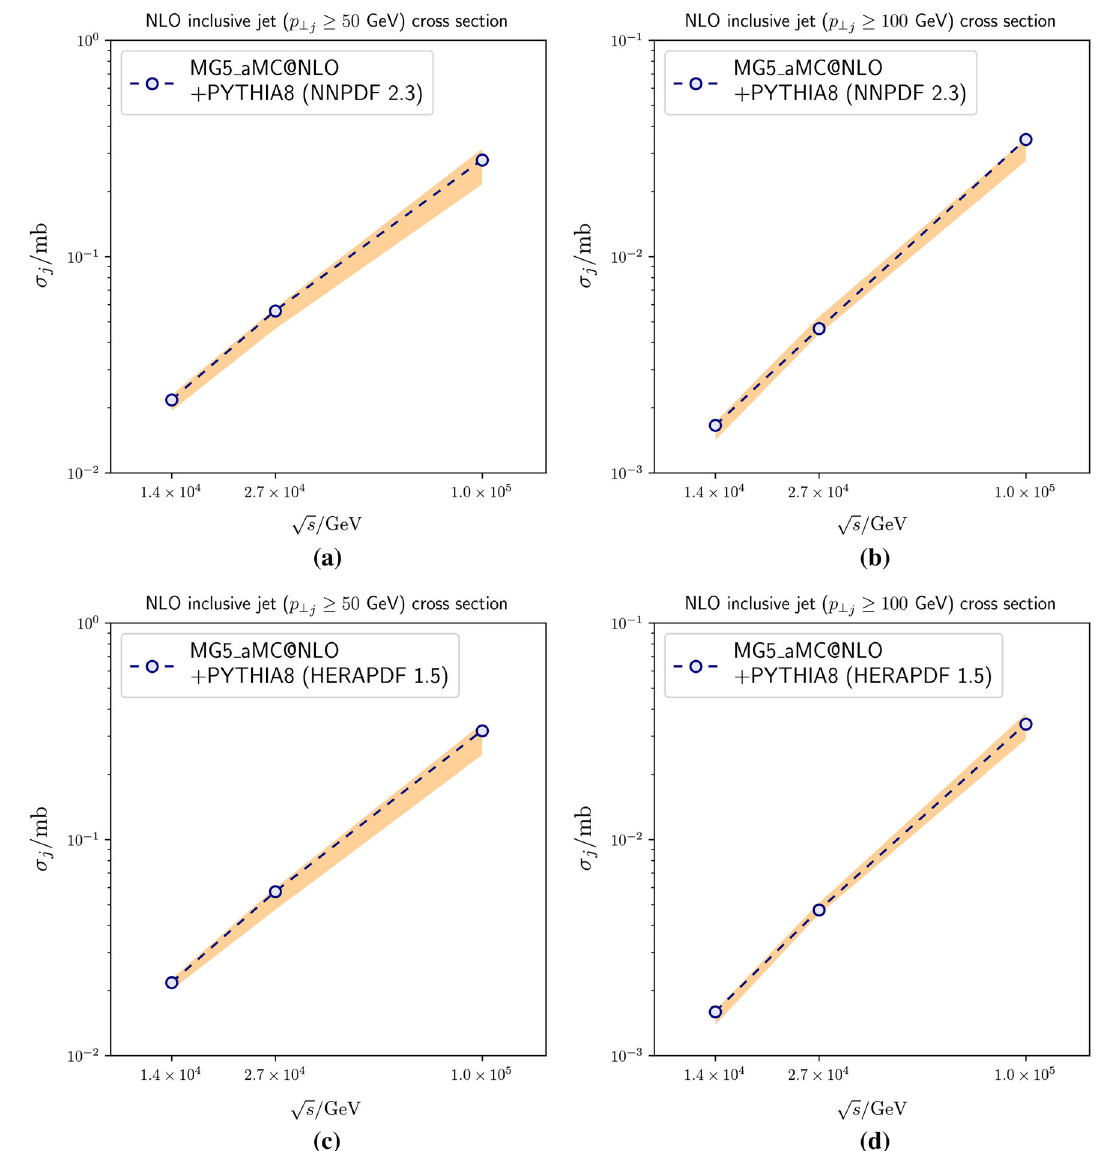
shaded bands denote scale variations with respect to μ R and μ F . a, b correspond tothe PDF setNNPDF 2.3, while c, d use the set HERAPDF